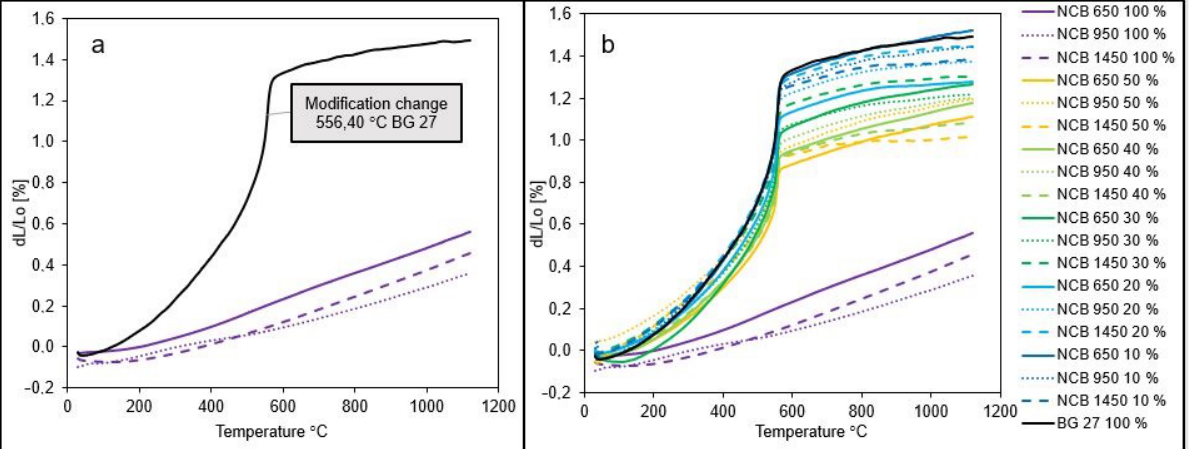
Figure 5. Dilatation curves for: ( a ) original silica and NCB sands in 100% content, ( b ) all tested pure and hybrid sand mixtures with various NCB contents.